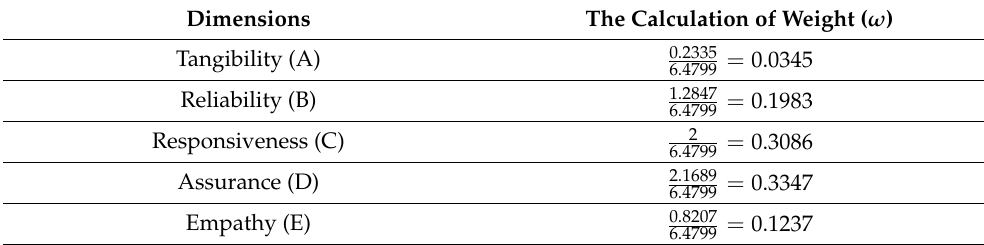
Table 6. The calculation of weight for five dimensions.